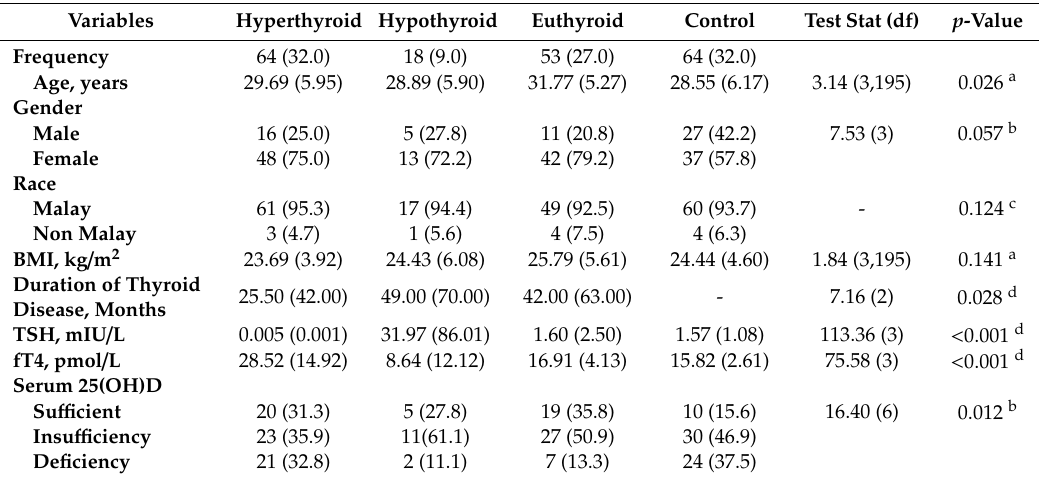
Table 1. Baseline characteristic of patients with thyroid disease and control